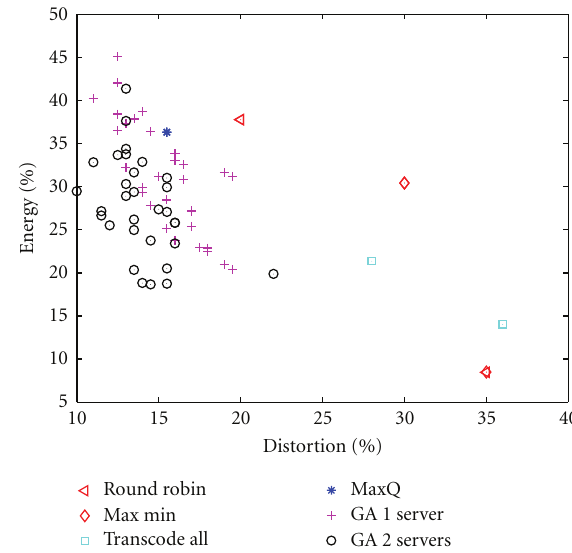
Figure 7: Bandwidth-distortion tradeo ff s.